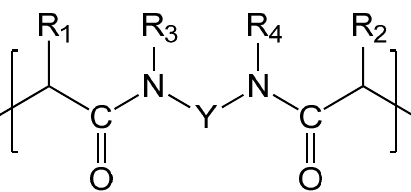
Figure 1. Chemical structure of cation- and anion-exchange EN-IEMs: R 1 and R 2 are each independently H or methyl; R 3 and R 4 are each independently H or alkyl, or R 3 and R 4 together